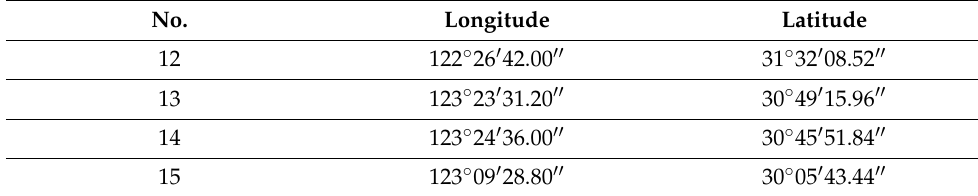
Table 3. Four key geographical points of an ECA.